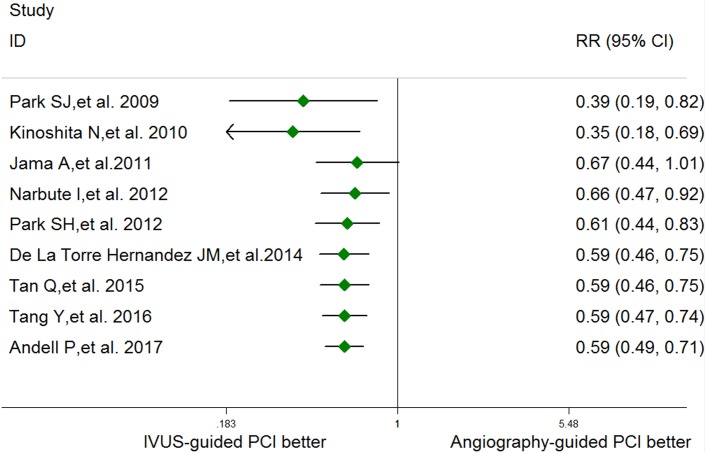
Results of cumulative meta-analysis in chronological order.